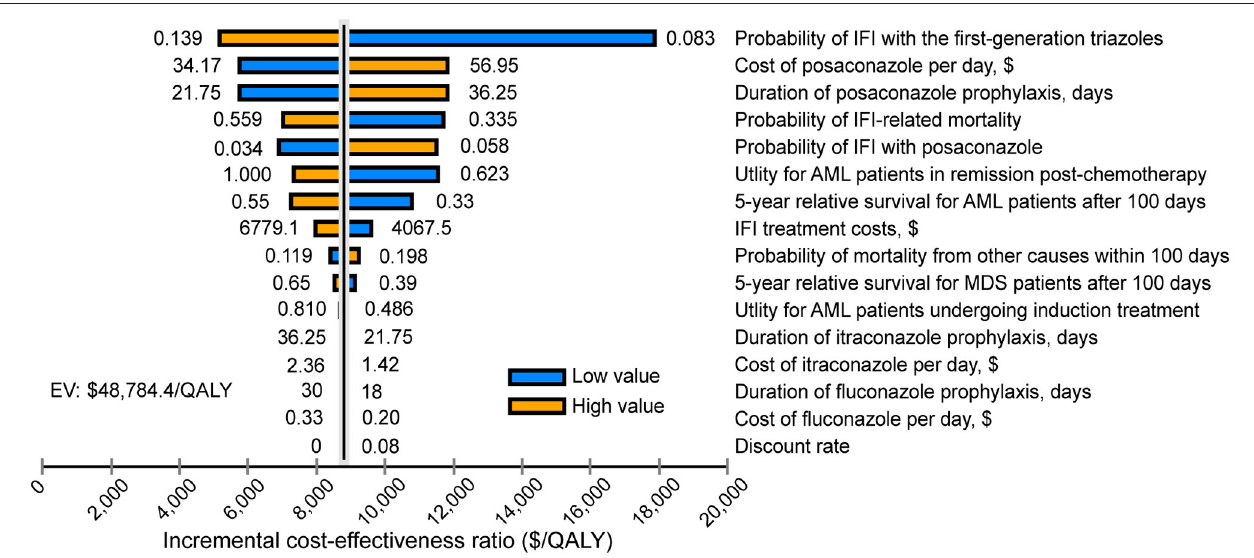
FIGURE 2 | One-way sensitivity analysis tornado